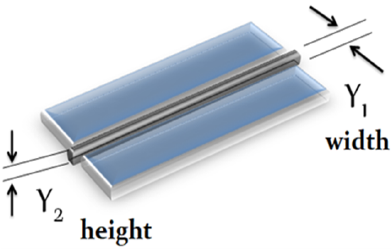
Figure 1. Multivariate Variable Y , Y = { Y 1 , Y 2